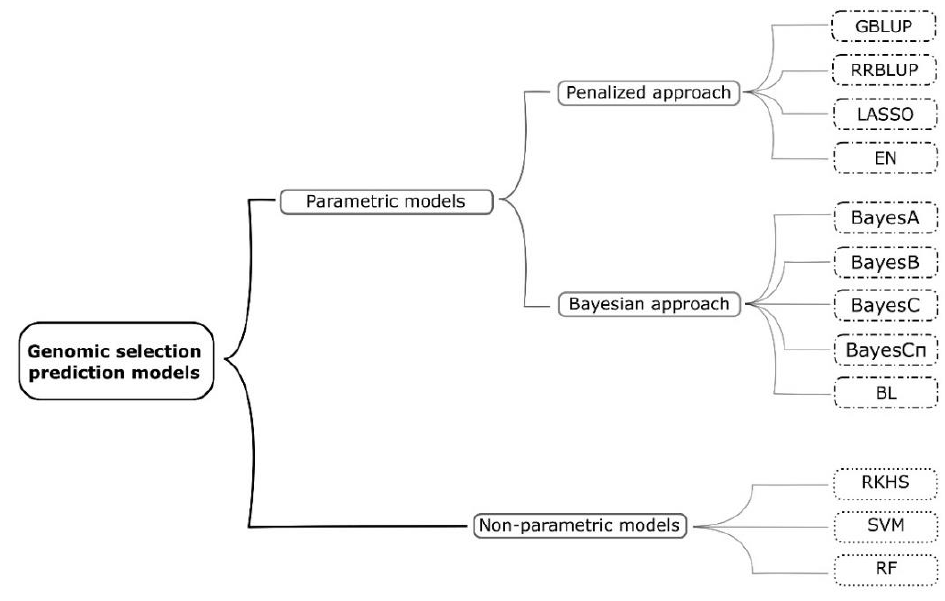
Figure 2. Classification of the most frequently used genomic selection prediction models.